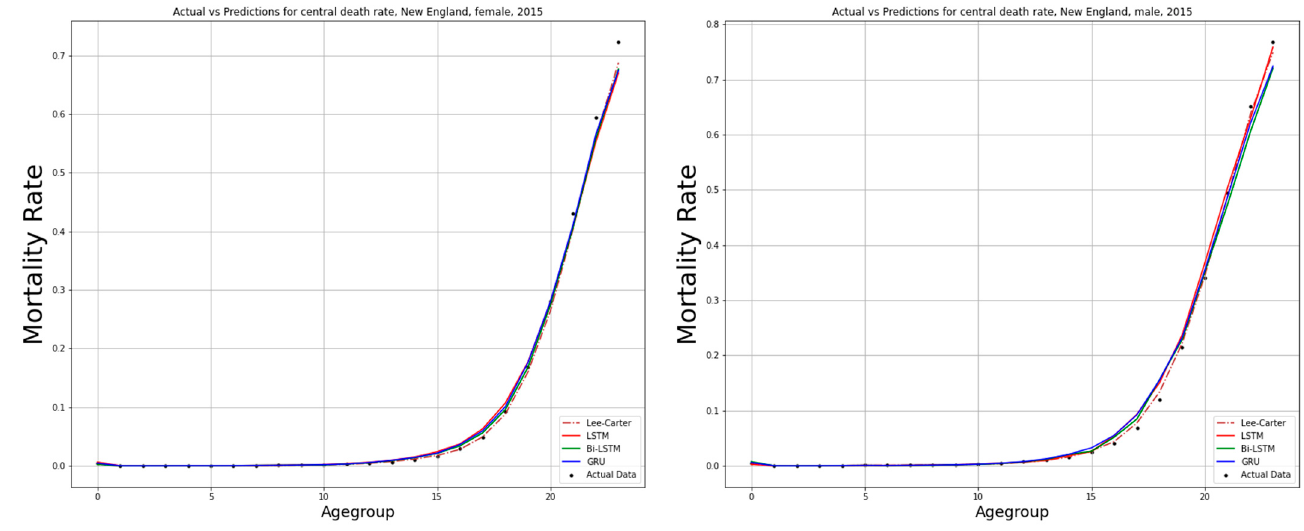
Figure 8. The predictions of the mortality rate for New England female ( left ) and male ( right ), 2015.